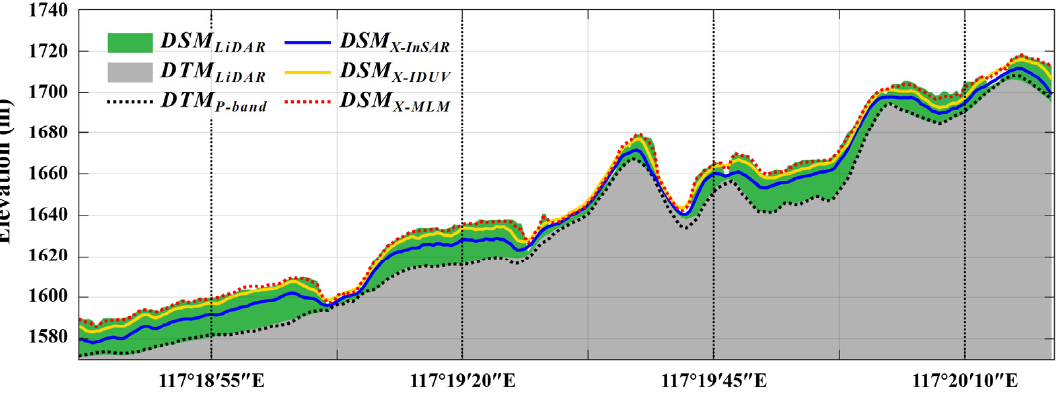
Figure 15. Elevation profile of DTM P-band , DTM LiDAR , DSM LiDAR , and DSM X-InSAR/IDUV/MLM (42°24 ′ 20 ″ N).